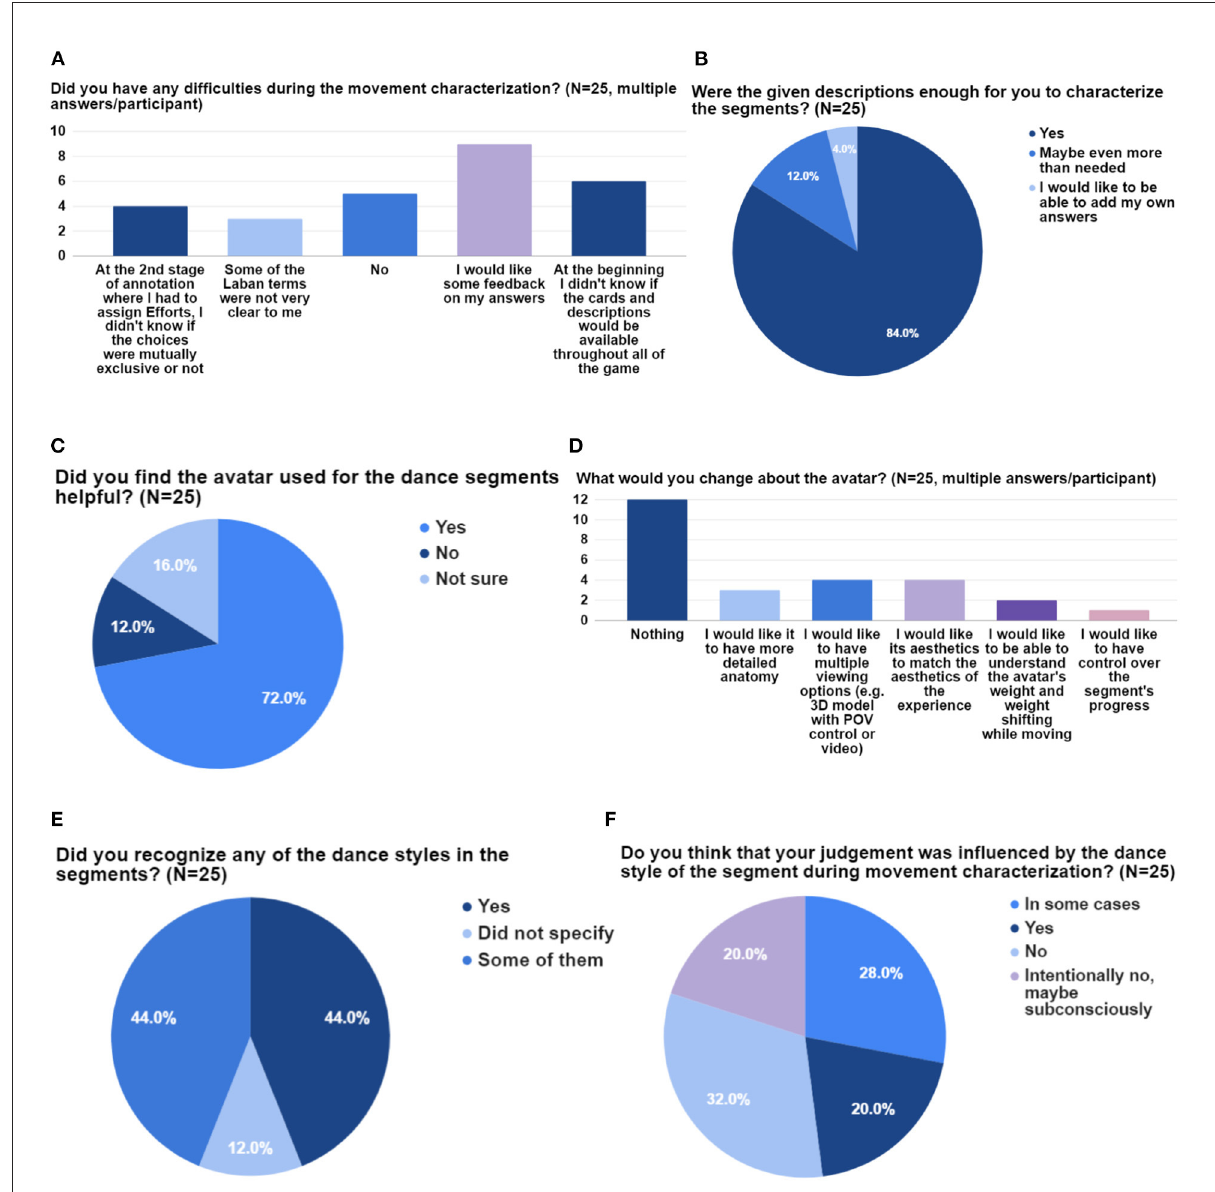
FIGURE10 Participants’ feedback on aspects of the annotation process. Panel (A) presents feedback on difficulties during annotation, panel (B) shows feedback on card descriptions, panel (C) shows participants’ feedback on whether the avatar was helpful (D) shows some of participants’ change suggestions about the avatar, panel (E) presents the participants’ feedback on whether they recognized the dance styles included in the segments and panel (F) shows their feedback on the influence of the different dance styles on their judgment during movement